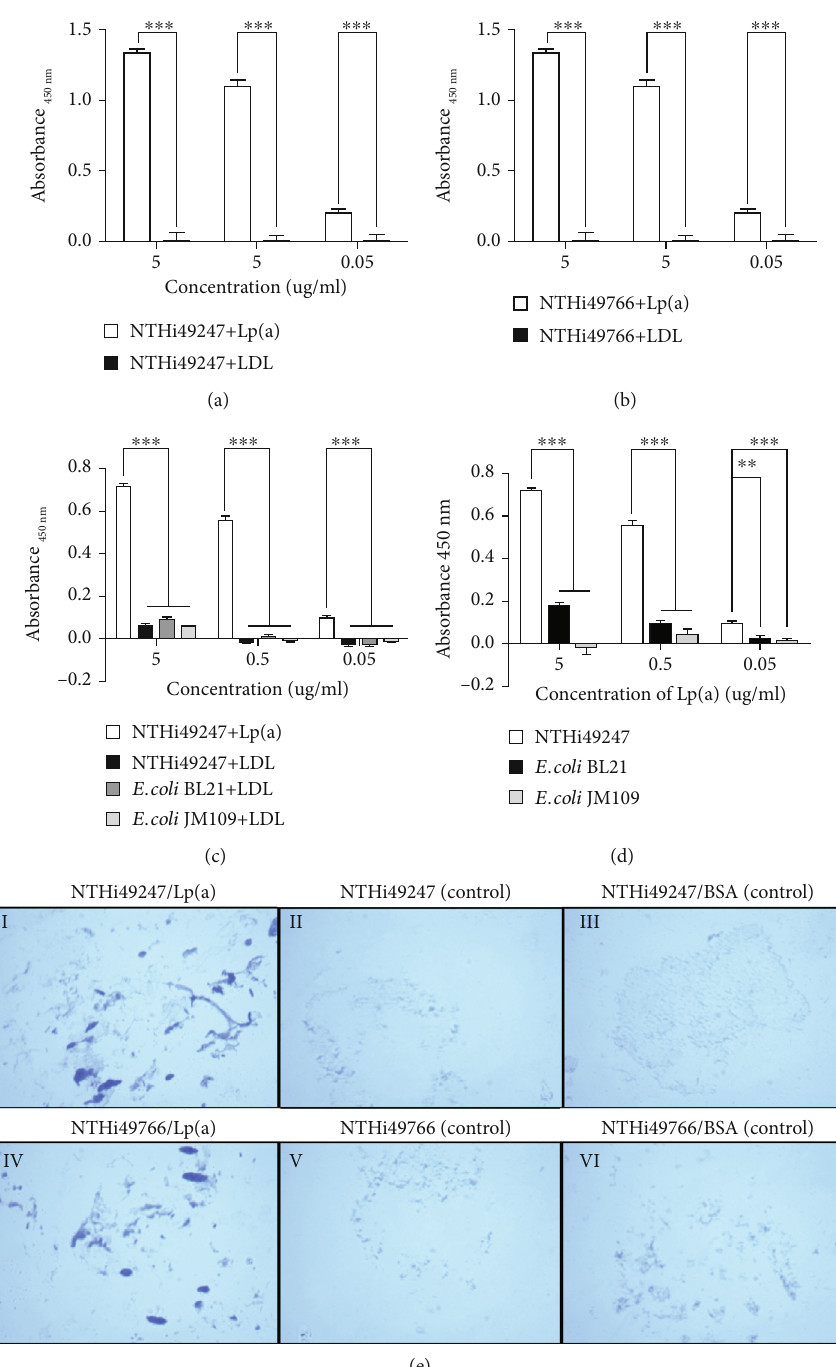
Figure 2: Interactions between Lp(a) and bacteria were analyzed by ELISA and bacterial adherence assay. (a – d) Binding of Lp(a) to bacteria was analyzed by whole-cell ELISA. Puri fi ed Lp(a) or LDL was added to intact bacteria at increasing concentrations (0.05 – 5 μ g/mL). The bound fraction of Lp(a) was measured using anti-apo(a) Ab, and that of LDL was measured using anti-LDL Ab. Lp(a) bound to each of the two strains of NTHi in a dose-dependent manner, whereas the negative control protein LDL did not (a, b). Two strains of E. coli showed weak binding to both Lp(a) and LDL (c, d). Data shown are mean values from three experiments conducted in duplicate, and error bars indicate SDs. Statistical signi fi cance was determined by two-way ANOVA and the Bonferroni post hoc test. ∗ P < 0 : 05 , ∗∗ P < 0 : 01 , and ∗∗∗ P < 0 : 001 . (e) Attachment of NTHi to immobilized Lp(a) was visualized by light microscopy after standard gram staining. Wells, either coated or uncoated with BSA, were included as negative controls. Representative images of two independent experiments are